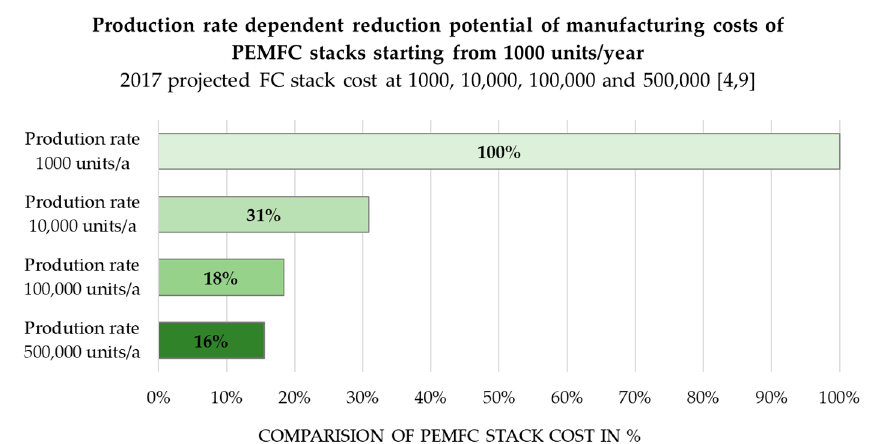
Figure 3. Production rate dependent reduction potential of manufacturing costs of PEMFC stacks starting from 1000 units/a based on [4,9].